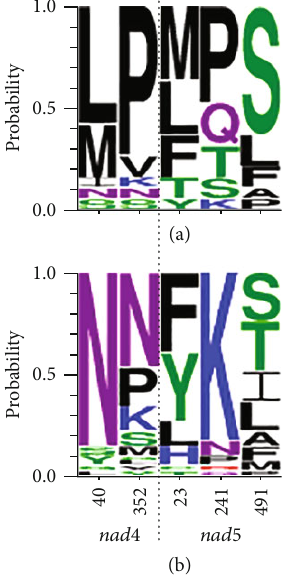
Figure 2: Amino acid composition of positively selected sites in Plethodontidae (a) and lunged salamanders (b). The color scheme of each amino acid represents the chemical properties, as determined using WebLogo 3: polar (green), neutral (purple), basic (blue), acidic (red), and hydrophobic (black).